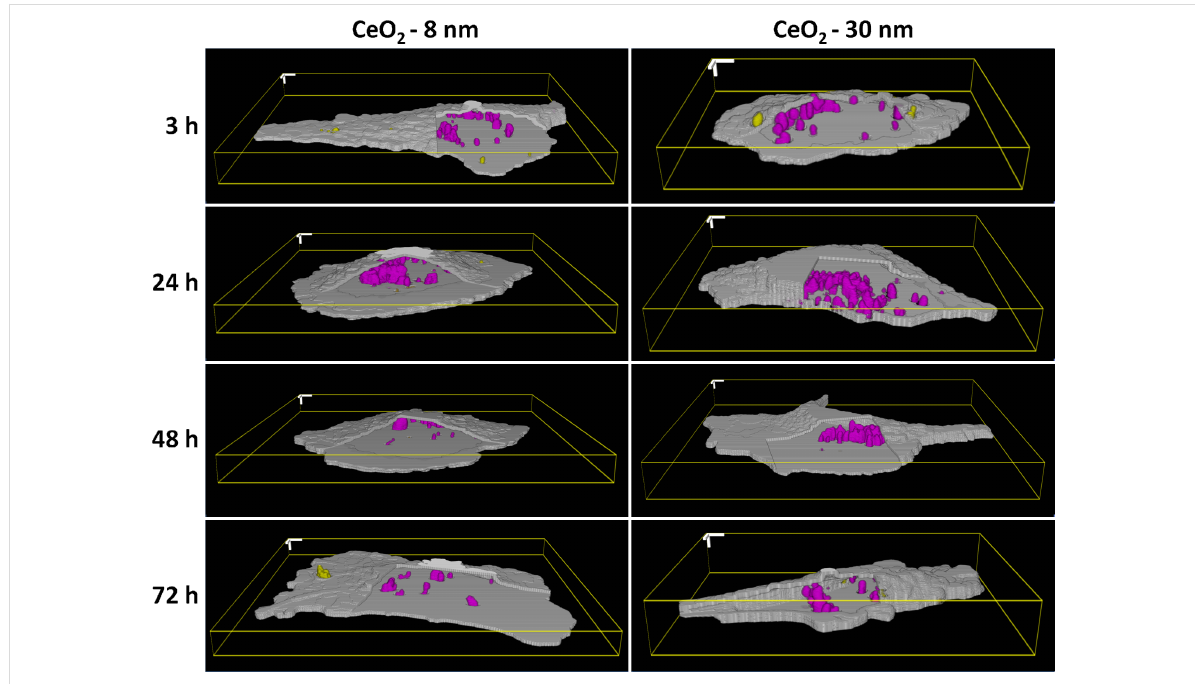
Figure 4: Particle size-dependent uptake kinetics of ceria nanoparticles by HMEC-1 cells. Representative three-dimensional images of 8 nm and 30 nm ceria nanoparticles interacting with endothelial cells for 3, 24, 48 and 72 h are shown. Due to the strong agglomeration of particles, the indi- vidual particles quantified by Particle_in_Cell-3D are actually individual agglomerates of 417 nm (CeO 2 -8 nm) and 316 nm (CeO 2 -30nm). The membrane region outlining the cells appears in gray. The intracellular nanoparticles can be visualized in magenta and particles interacting with the membrane appear in yellow. The agglomerates are taken up by cells inside endosomes and accumulate at the perinuclear region. The amount of internalized particles is increasing over 24 h, but after this incubation time, however, the number of particles inside the cells starts to decrease. This effect is more remarkable for the 8 nm nanoparticles than for the 30 nm nanoparticles. 3D scale bars = 5